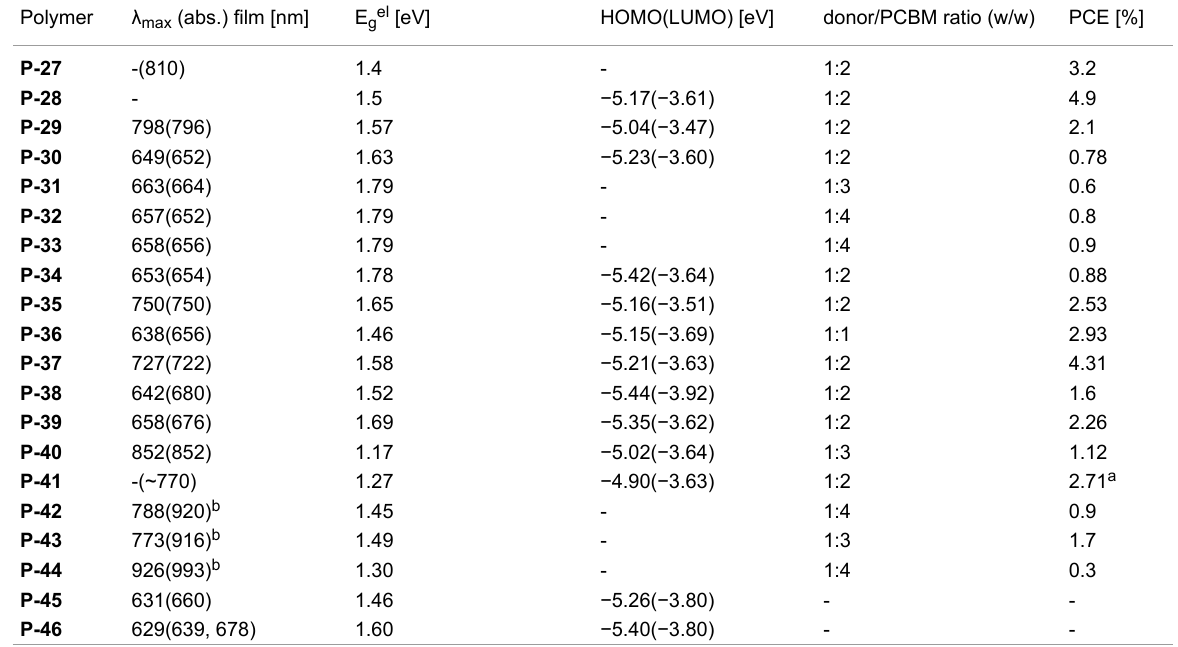
Table 6: Thienyl-substituted DPP polymers and their use in photovoltaic devices (properties that are of interest with regard to photovoltaic devices).